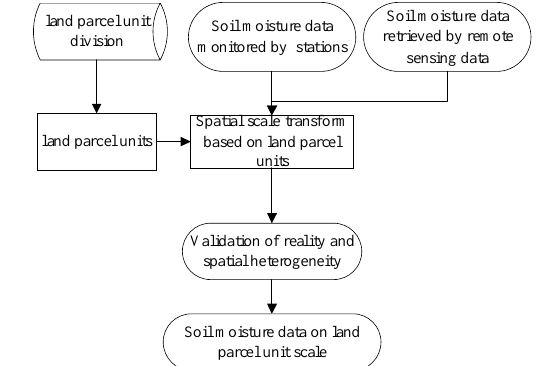
Figure 1. Spatial scale transformation flow of multisource soil